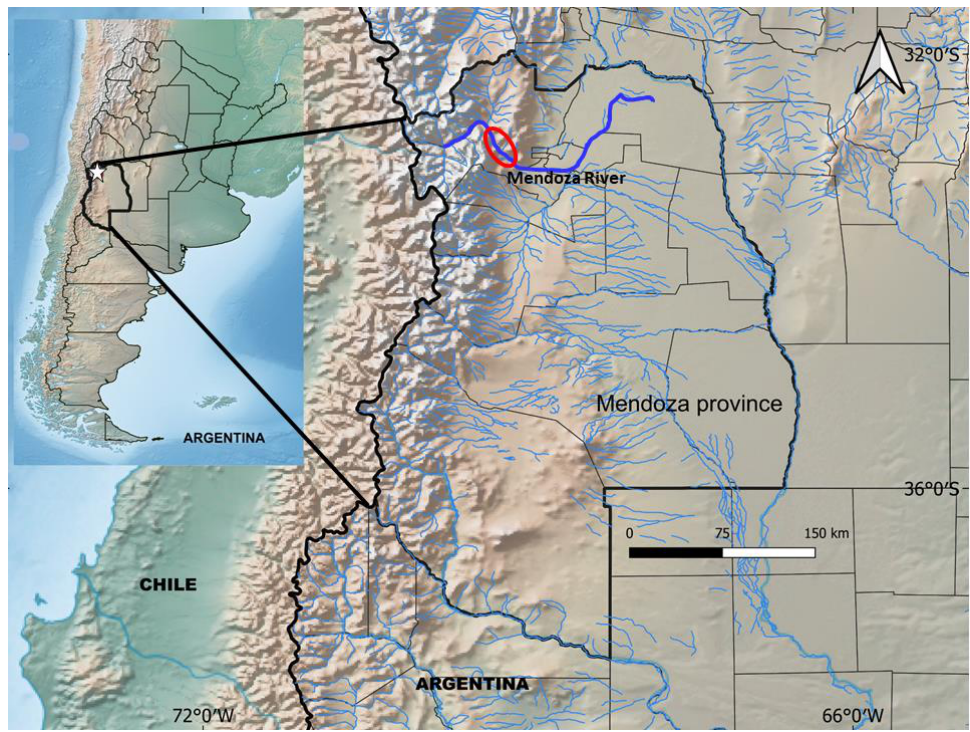
Figure 1. Map of the Central Andes range (Argentina). The red ellipsis encloses the section of the river (the middle section of the Mendoza River basin) where the fish were collected.